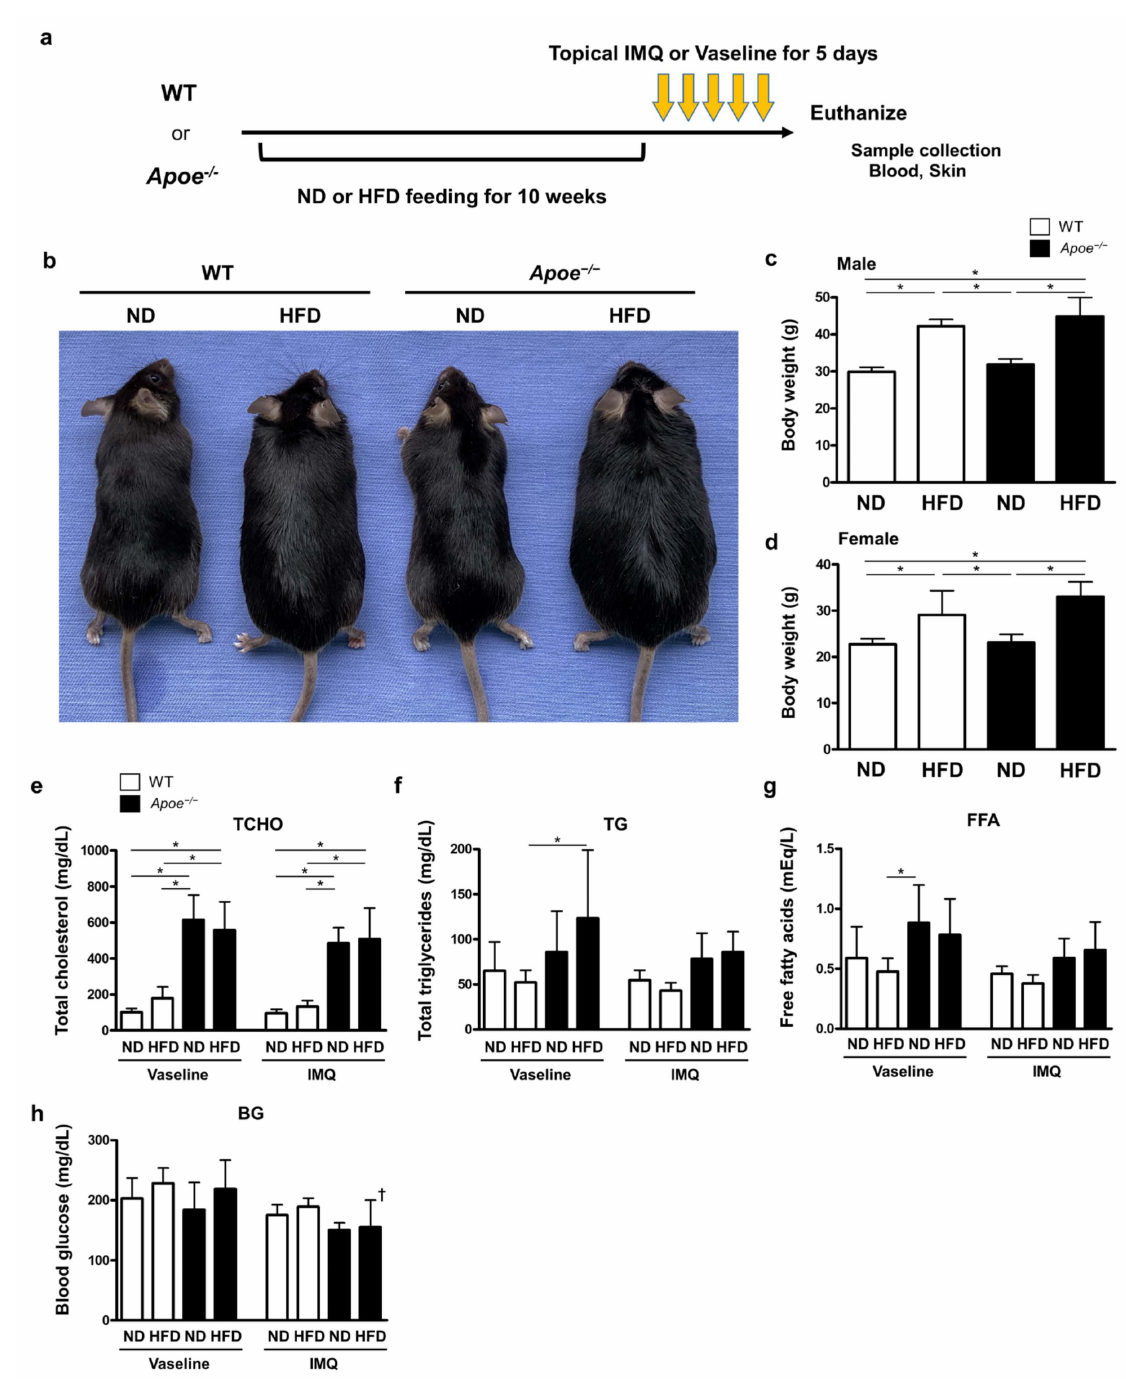
Figure 1. High-fat diet feeding and Apoe deficiency provoked remarkable metabolic changes. ( a ) Study design: Ten-week-old WT and Apoe − / − mice were fed with ND or HFD for 10 weeks. IMQ cream (25 mg/mouse) or Vaseline (as control) were topically applied on the ear for 5 consecutive days ( n = 6 per group). One day after the last treatment, fasting sera and ear tissues were collected. ( b ) Mouse appearance. ( c , d ) Body weights of male and female mice. ( e – h ) Serum metabolic parameters: Serum concentrations of total cholesterol, triglyceride, free fatty acid, and blood glucose were determined by biochemical assays. Values are presented as the mean ± standard deviation; * p < 0.05, † p < 0.05, compared to Vaseline-treated mice. IMQ, imiquimod; WT, wild-type; ND, normal diet; HFD, high-fat diet; TCHO, total cholesterol; TG, triglyceride; FFA, free fatty acid; BG, blood